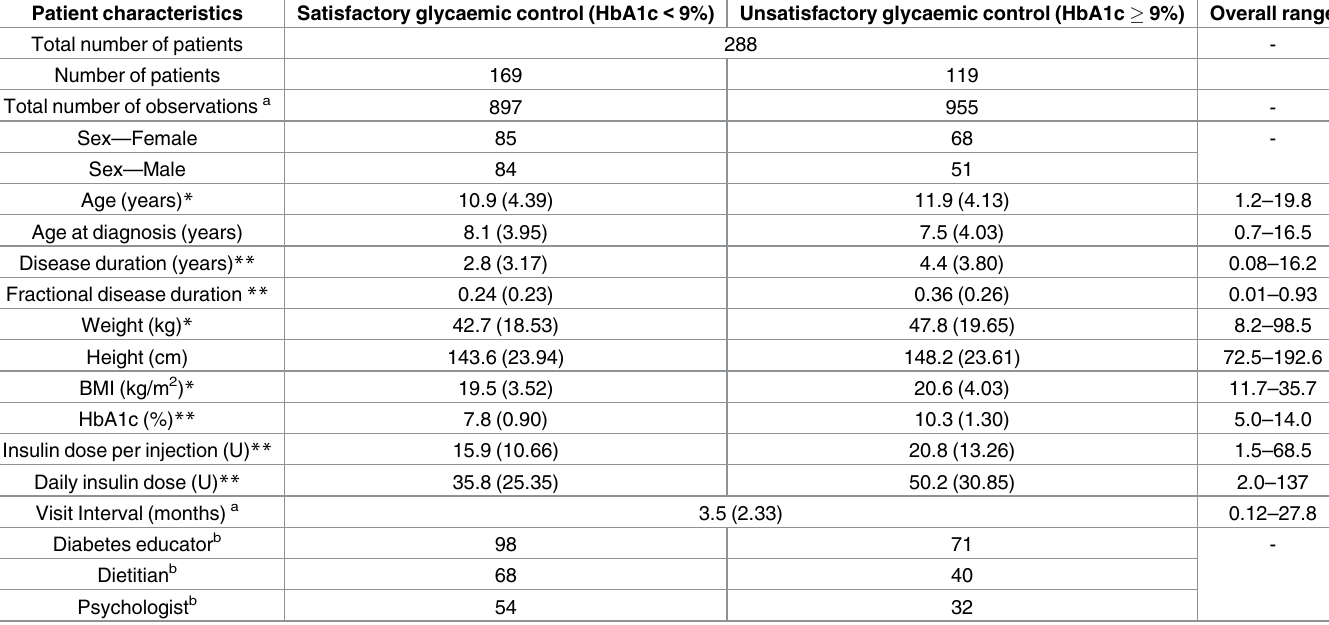
Table 1. Patient characteristics at the start of the observation period. Patient